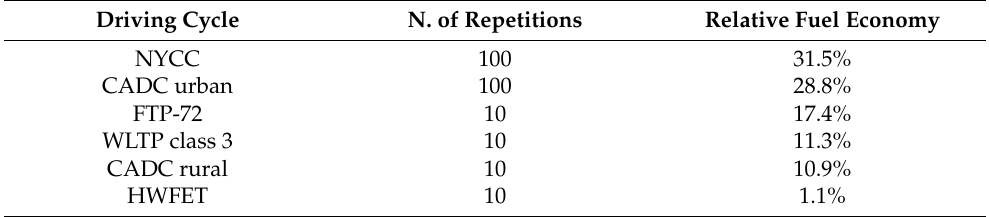
Table 6. Results of Causal ECMS-based ( Q = 1000) applied to the driving cycles listed in Table 2 in terms of Relative Fuel Economy (RFE) with multiple repetitions of the test cycles.